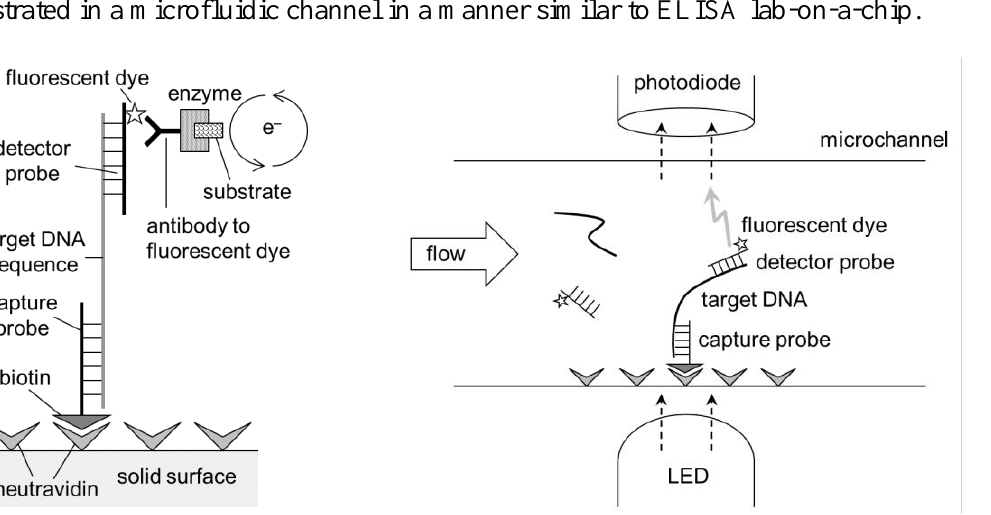
Figure 10. Left : A short sequence of DNA captures a target, complementary sequence, and a subsequent signal is detected in a manner similar to ELISA. Right : The same is demonstrated in a microfluidic channel in a manner similar to ELISA